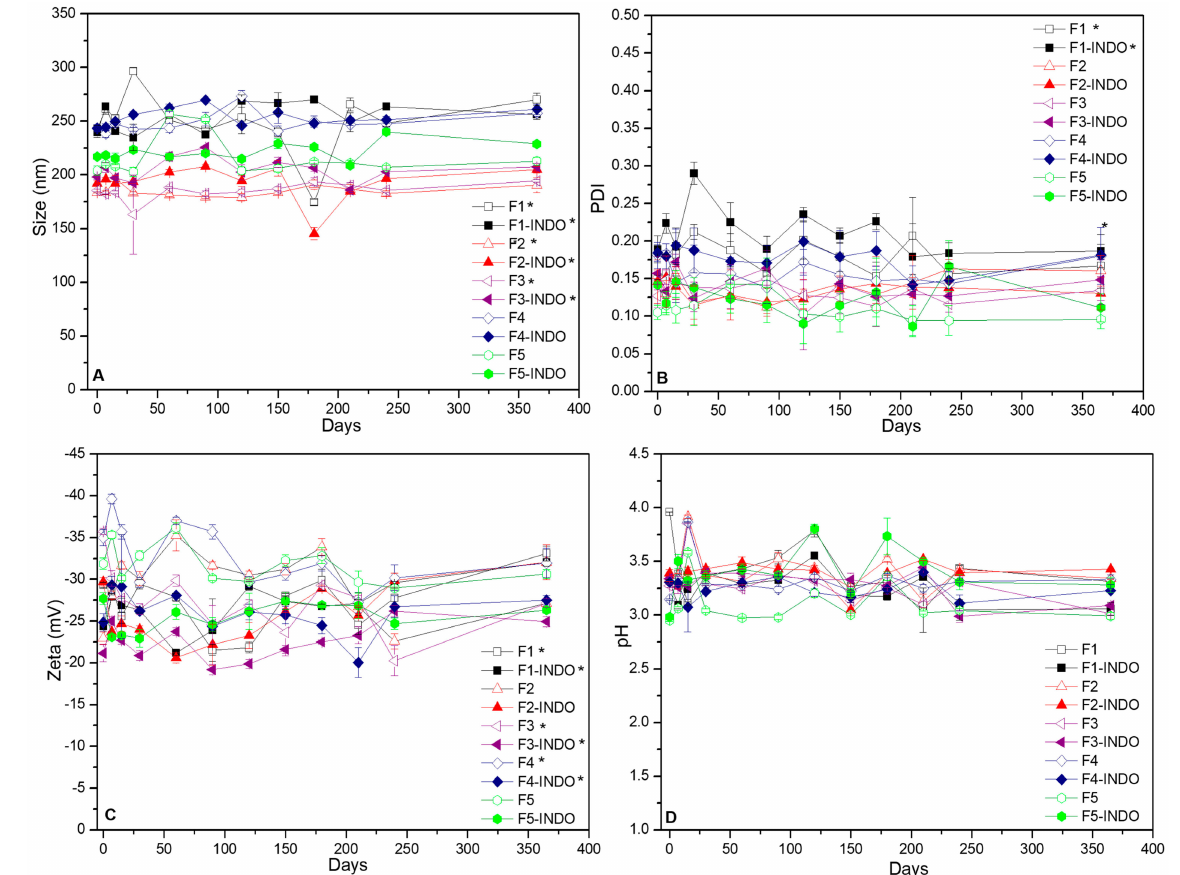
Figure 1. Long-term stability of NLC formulations, monitored in terms of size ( A ), PDI ( B ), Zeta potential ( C ) and pH ( D ) values for up to a year, at 25 ◦ C ( n = 3; p < 0.05).